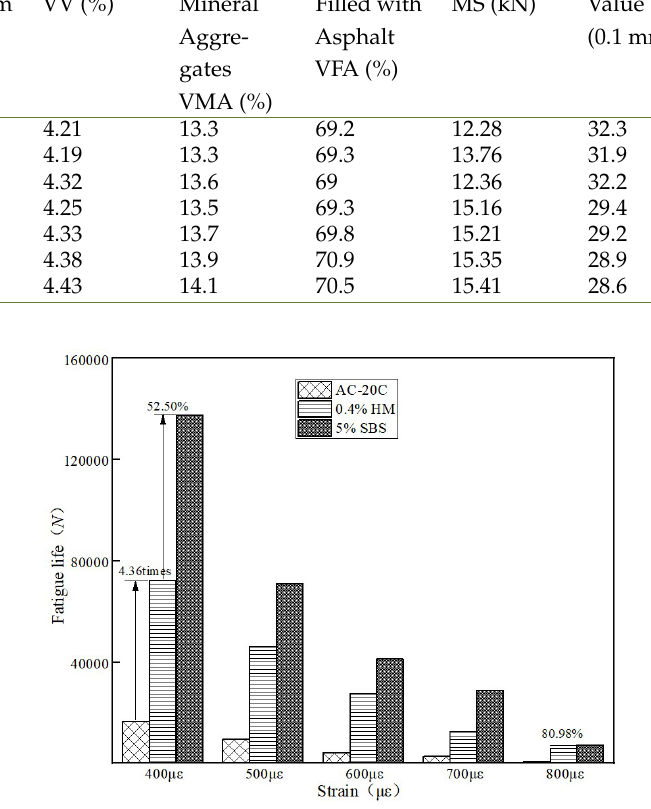
Fig. 2. Fatigue performance life of high-modulus asphalt mixture